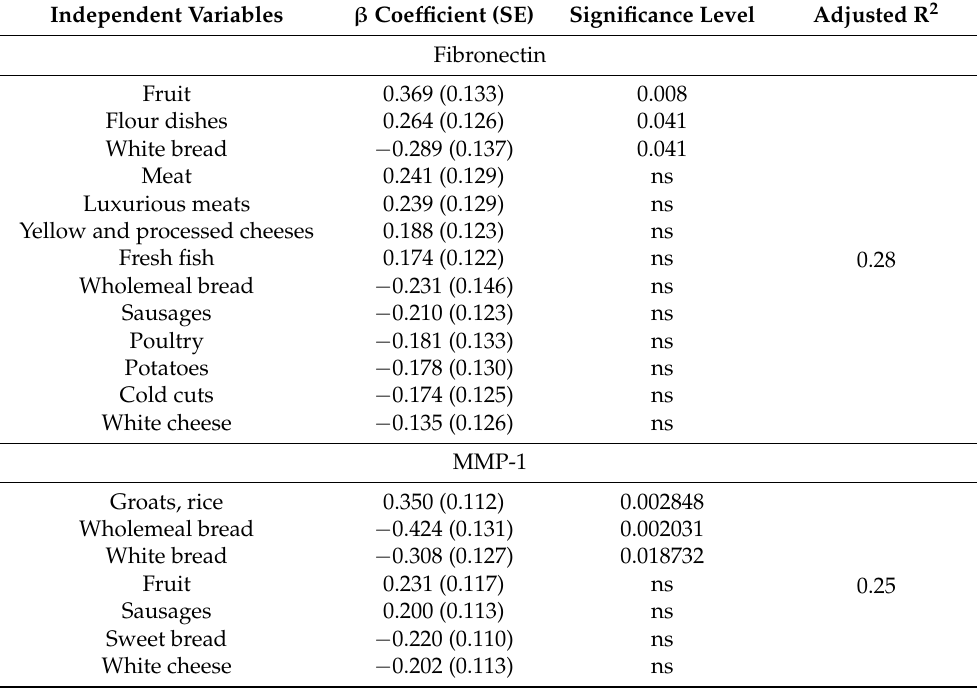
Table 4. Stepwise linear regression analysis of multiple effects of food consumption frequency on the concentration of fibronectin and MMP-1 in the serum of patients with Alzheimer’s